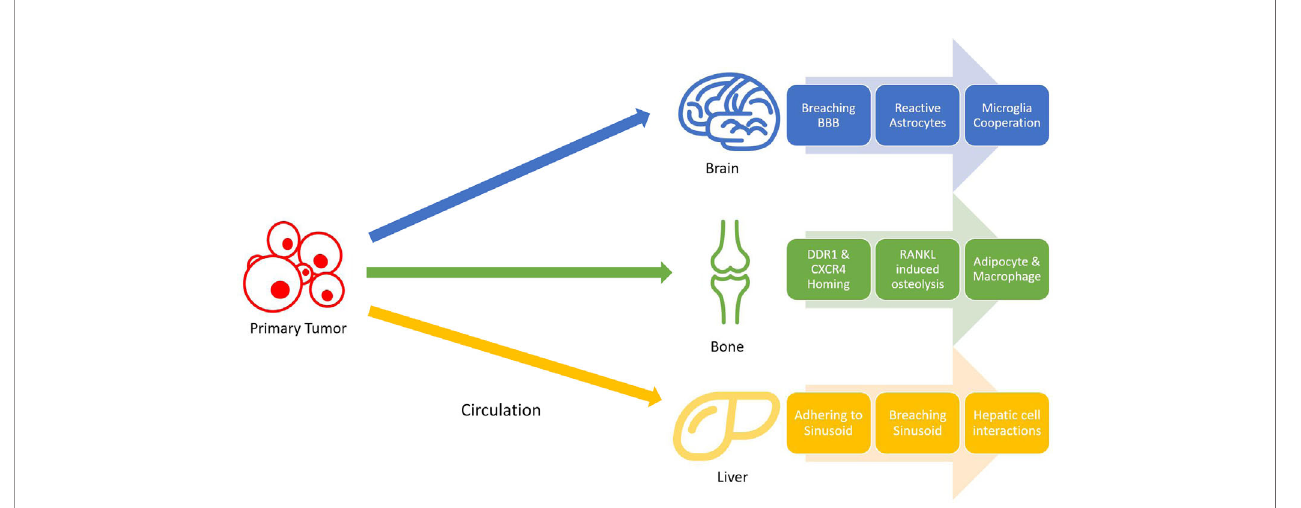
FIGURE 1 | Non-small cell lung cancer (NSCLC) metastasis stages. Tumors cells gain mobility and intravasate into bloodstream, where they will travel to distant organs and extravasate. Once in the target organ tissues, tumor cells adapt to their surroundings by resisting local immune attacks and cooperating with different